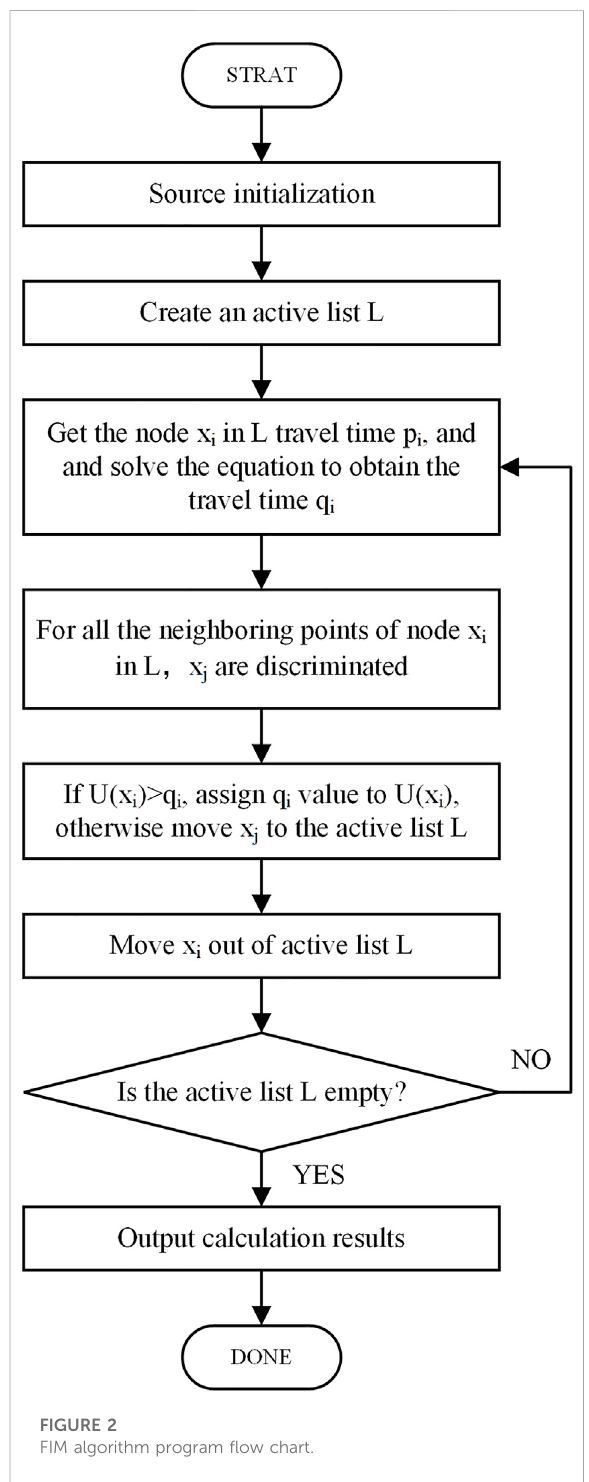
FIGURE 2 FIM algorithm program fl ow